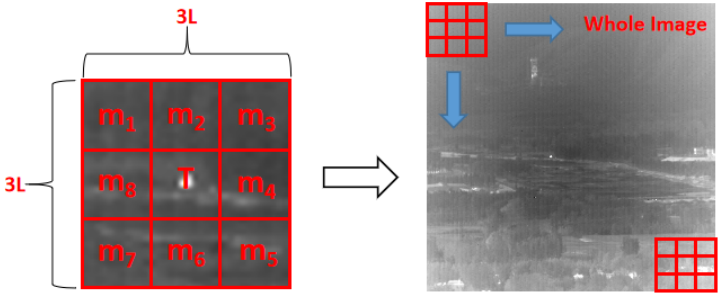
Figure 4. Structure of the nested sliding window, where L is the length of the